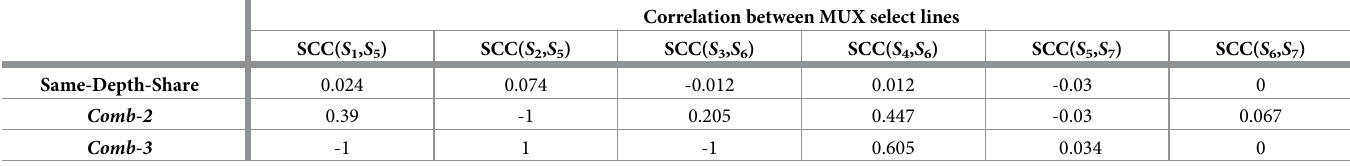
Table 2. Correlation between selection lines of mutually reachable MUXes.